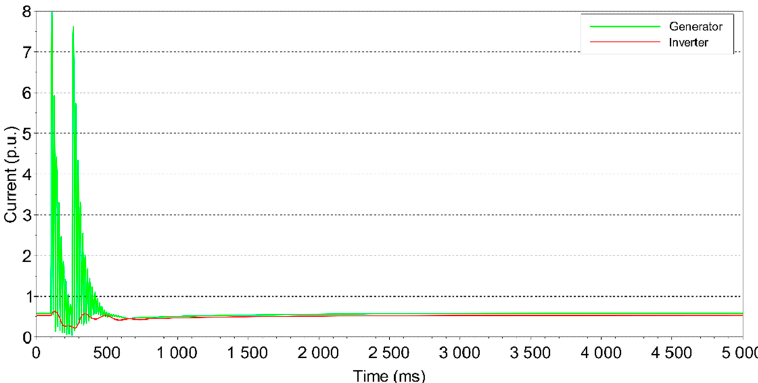
Figure 19. Currents of the induction generator and inverter output for ride-through analysis.